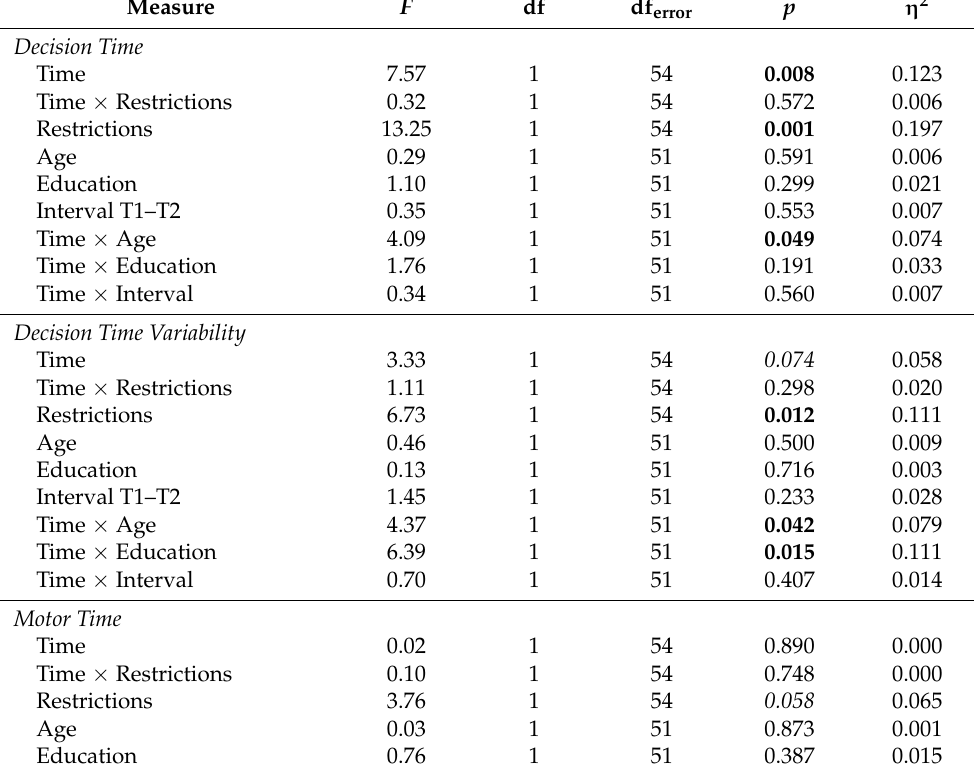
Table 2. Repeated measure ANCOVA results. Significant effects ( p < 0.05) are in bold, marginally significant effects ( p < 0.10) in